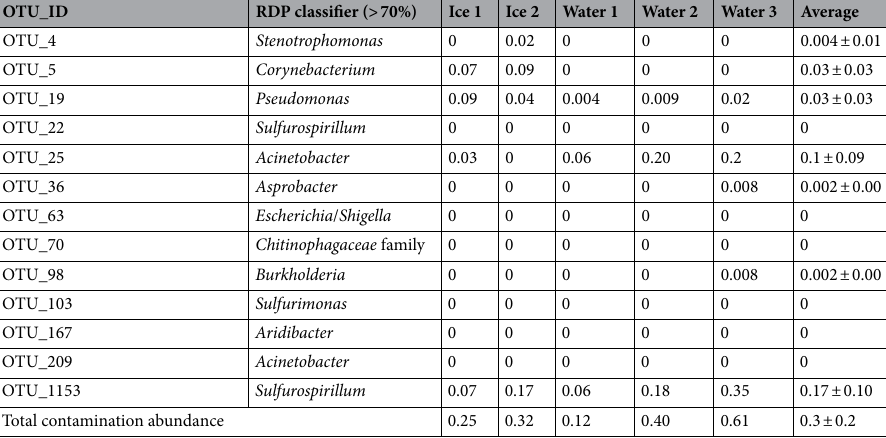
OTU_ID RDP classifier (>